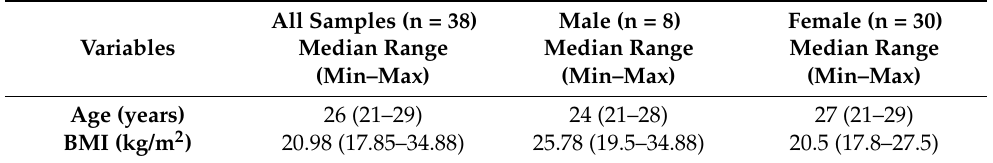
Table 1. Descriptive statistics of subjects’ demographics.